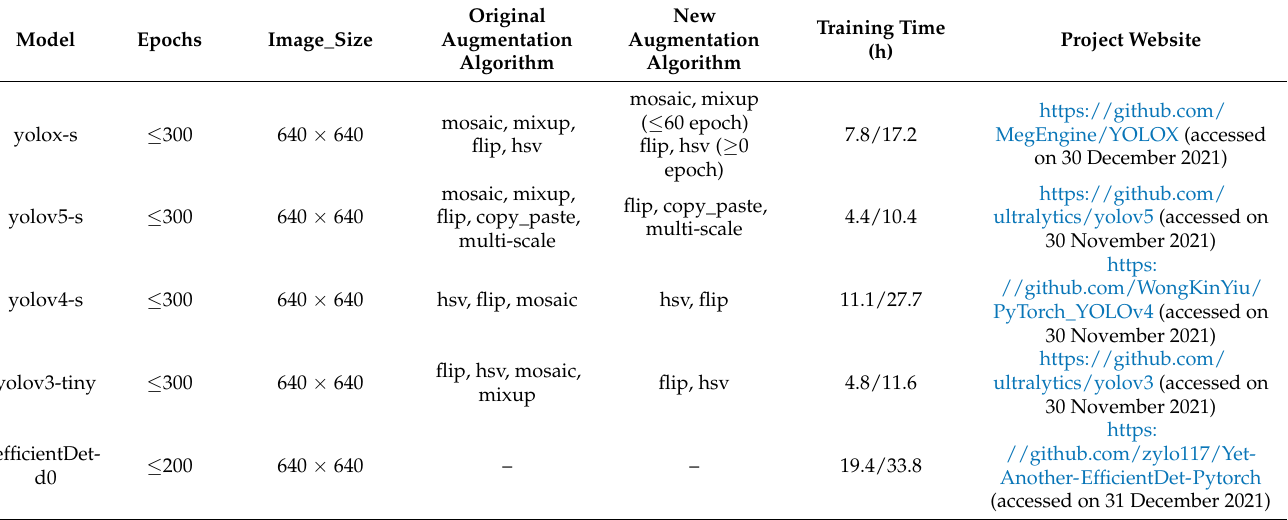
Table 3. Information for each